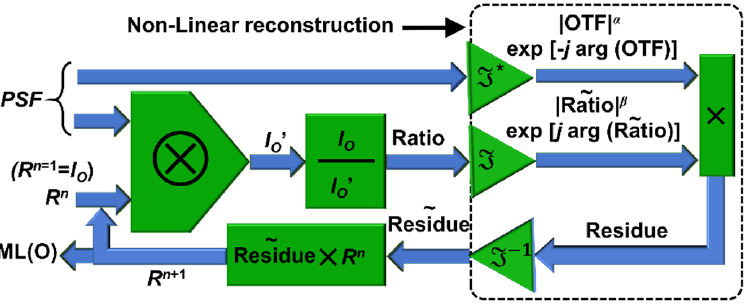
Figure 2. Schematic of LRRA. ML—maximum likelihood; OTF—optical transfer function; n —number of iterations; ⊗ —2D convolutional operator; F ∗ —refers to complex conjugate following a Fourier transform.